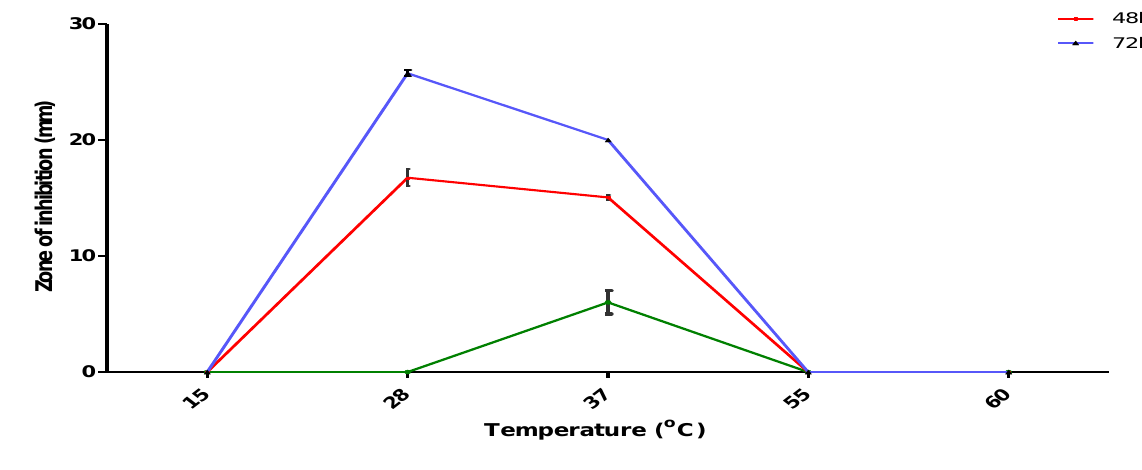
Figure 5. Effect of pH on the haemolytic activity of Stenotrophomonas acidaminiphilis